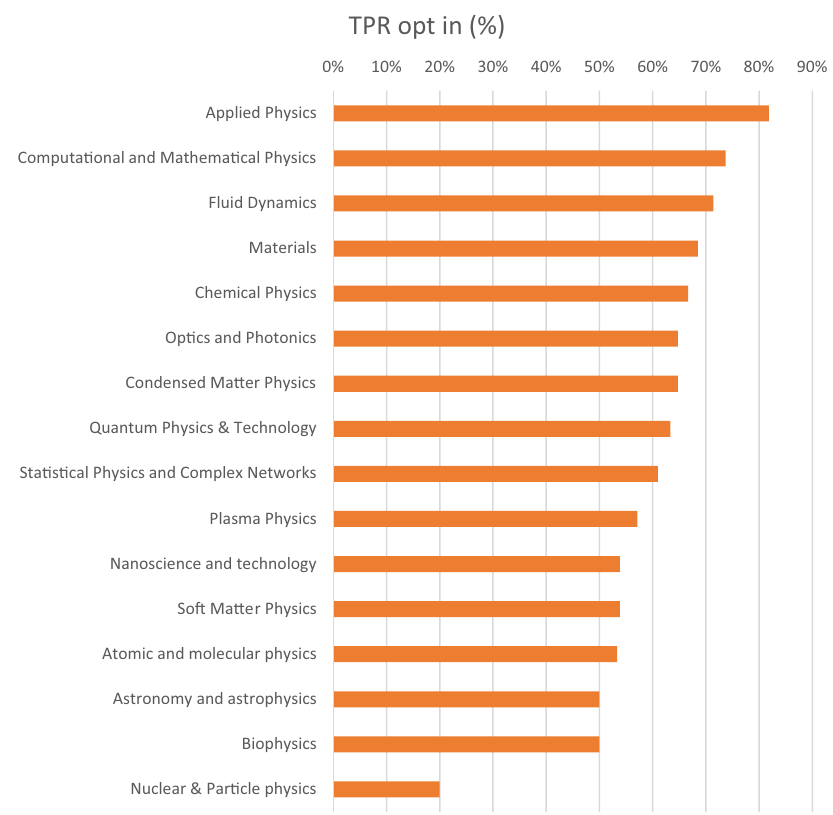
Fig. 1 Subject distribution of distribution of transparent peer review (TPR) opt-in. Distribution of TPR opt-in across sub-disciplines of articles published in Communications Physics .